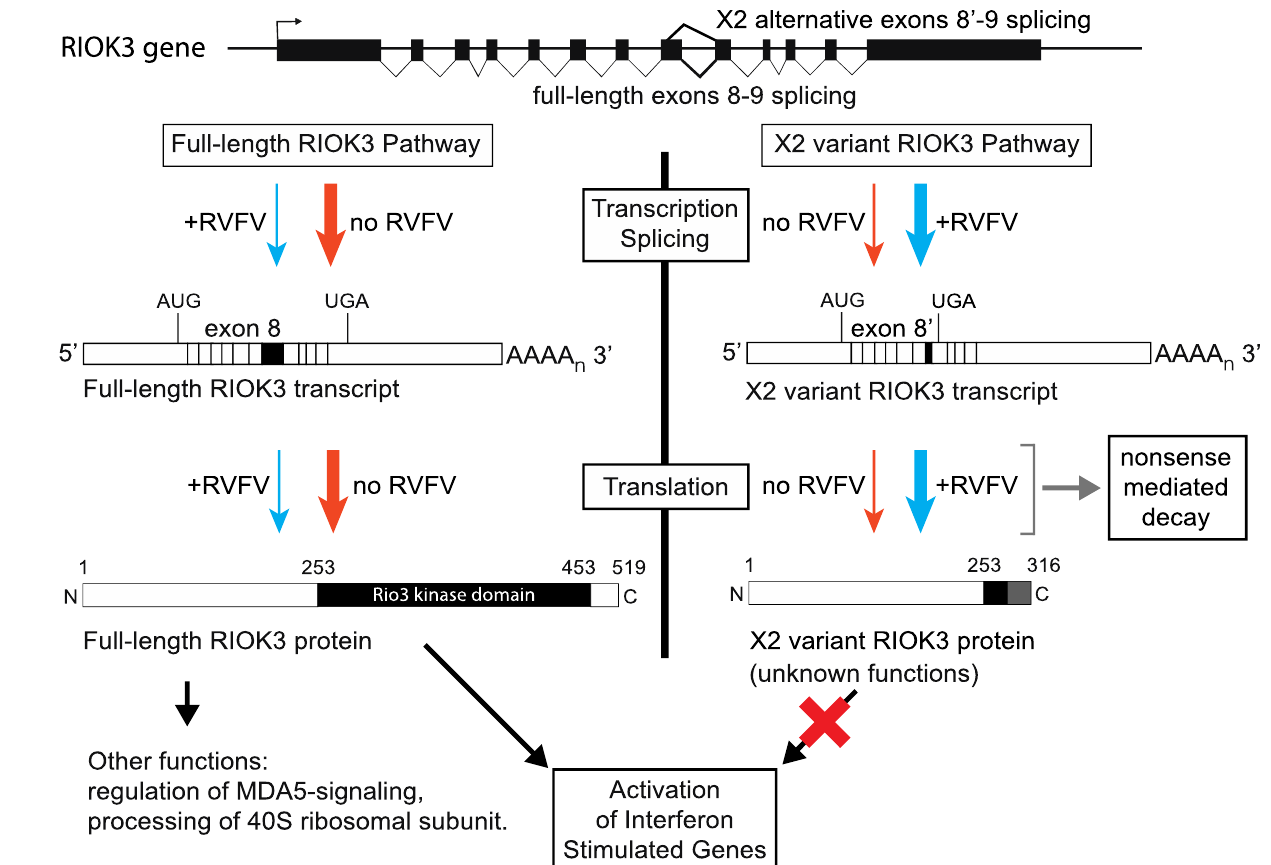
Figure 6. Relationship between RIOK3 splicing products, RVFV MP-12 infection, and innate immune activation. The human RIOK3 gene is represented at the top of the panel with its 13 exons. The normal RIOK3 protein with a complete kinase domain is called full-length and produced by translation of a canonically spliced transcript encompassing the 13 exons (left side of figure). Alternative 5' splice donor usage shortens exon 8 and results in the X2 variant mRNA. Translation of the X2 mRNA would produce a truncated RIOK3 missing most of the kinase domain (right side of figure). Notably, the X2 RNA contains an exonic premature termination codon making it a canonical substrate for nonsense-mediated decay and rapid degradation. The effects on RIOK3 gene expression during MP-12 infection (blue arrows) compared to uninfected cells (orange arrows) are shown. The magnitude of the effect is represented by the thickness of each arrow. It is not known if the X2 variant RIOK3 protein is expressed or stable, or if it possesses any function. By contrast, the full-length RIOK3 protein has been suggested to be involved in several diverse cell functions and pathways (see text), thus the relative expression levels of full length and X2 variants of RIOK3 can have strong effects on cellular functions including the antiviral response.